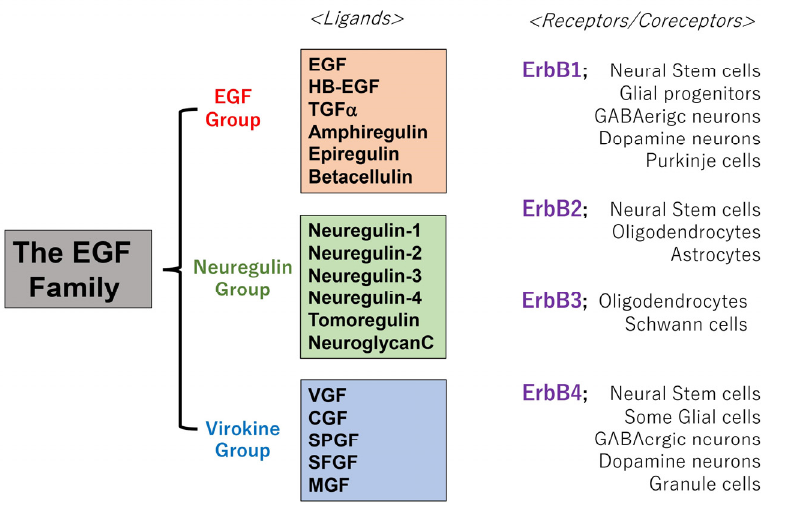
Figure 1. Groups and members of the EGF family and their receptors. Many EGF-like peptides structurally form the EGF family. These peptides are released from membrane-anchored precursor proteins via ectodomain shedding. These peptides bind to their receptor ErbB1-4 (Her 1-4) and induce intracellular signaling, although their interaction with ErbB2 is modest [16]. EGF receptor is abbreviated to EGFR alternatively. The localization of these receptors is shown in this figure. Abbreviations: EGF (epidermal growth factor), HB-EGF (heparin-binding EGF-like factor), TGF α (transforming growth factor alpha), VGF (vaccinia virus growth factor), CGF (cowpox growth factor), SPGF (smallpox growth factor), SFGF (shope fibroma virus growth factor), MGF (myxoma virus growth factor).